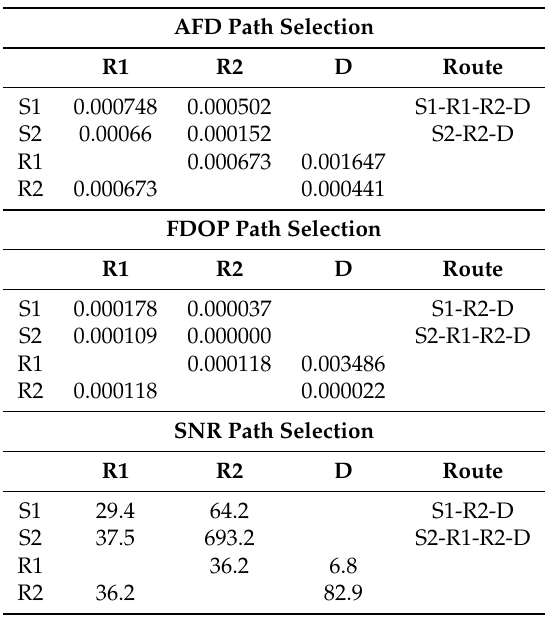
Table 1. Examples with Two Sources and Two